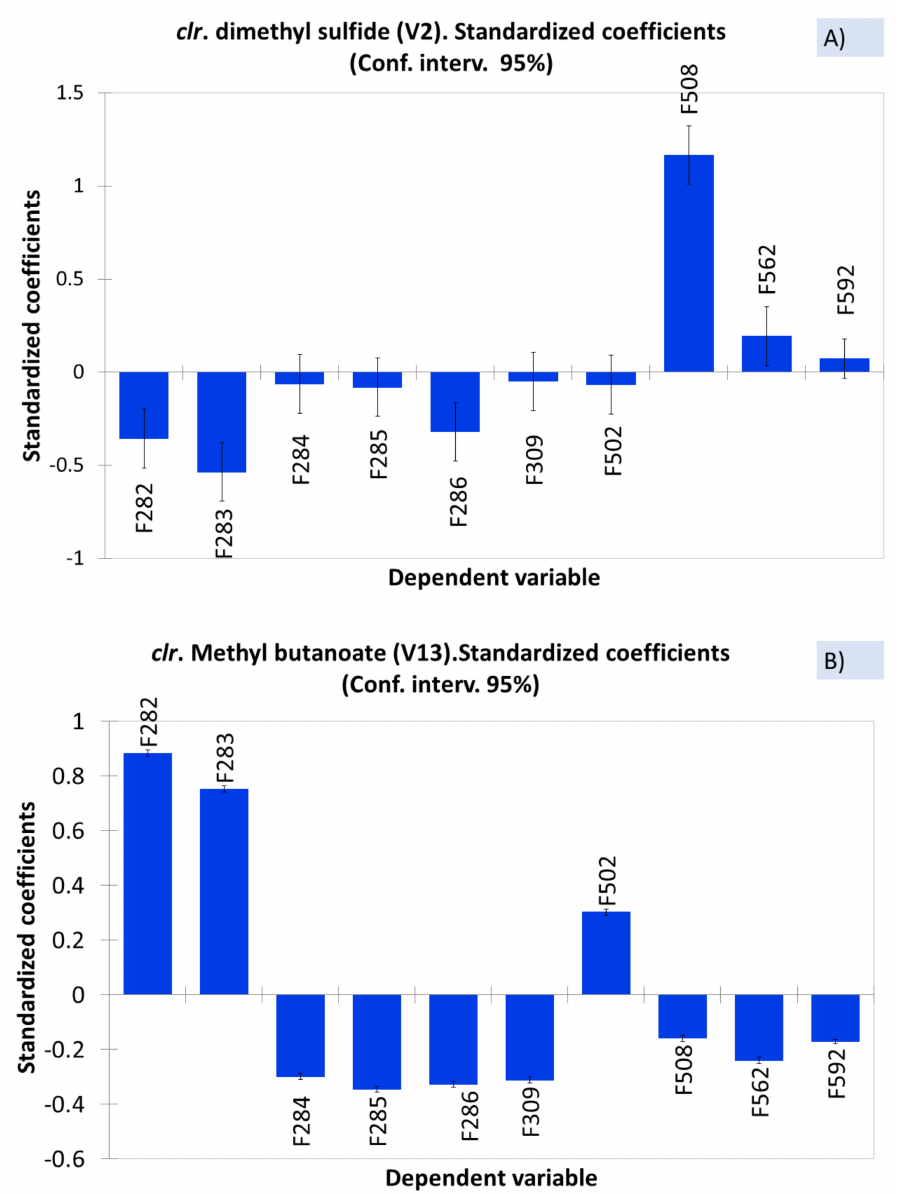
Figure 2. Example of the samples’ contribution to dimethyl sulfide ( A ) and methyl butanoate ( B ) (as clr coefficients ), based on the standardised ANOVA coefficients. Symbols of samples correspond to industry A (F282 and F283, affected by butyric spoilage; F284, F285, F286, and F309, normal fermentations) and industry B (F508 and F562, affected by sulfidic and putrid spoilages, respectively; F502 and F592, normal